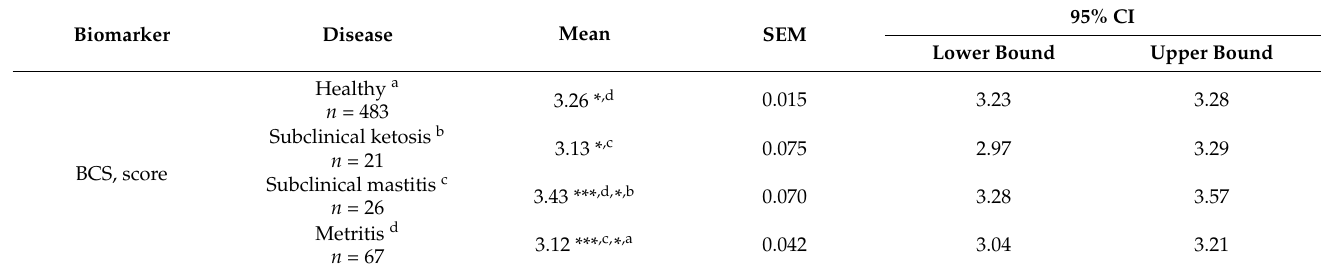
Table 4. Means and standard errors of the mean of the body condition score based on the health status of cows.